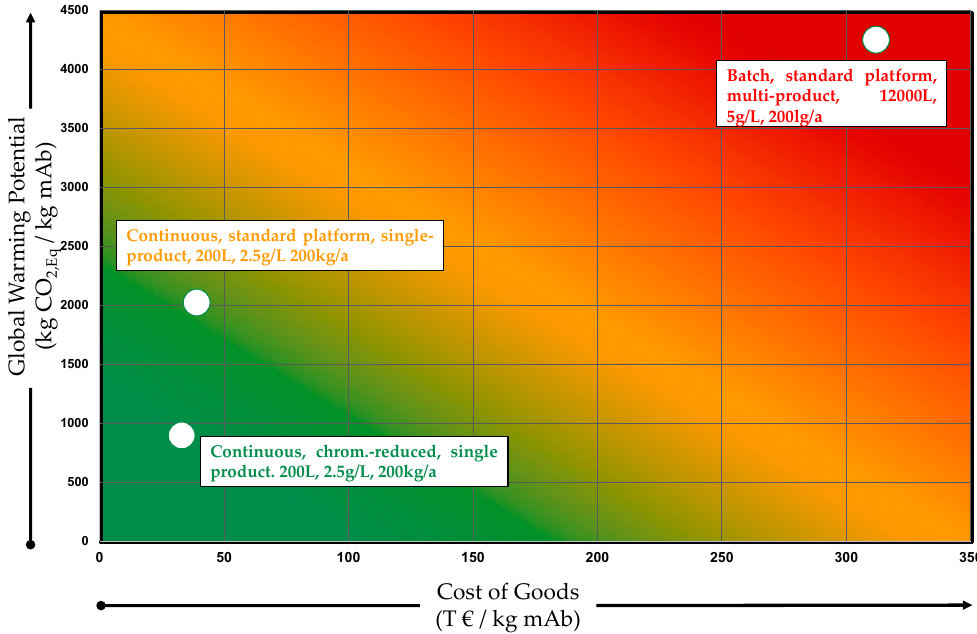
Figure 3. Biologicals’ global warming potential (GWP) vs. cost of goods (COGs) portfolio. Monoclonal antibody (mAb).